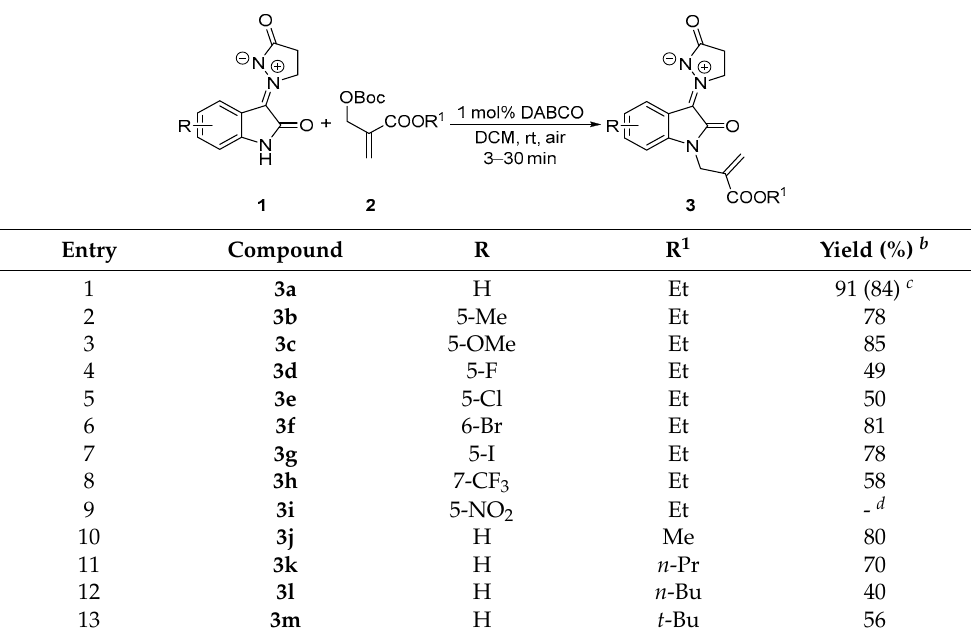
Table 2. Synthesis of N -allylated products 3 from isatin N , N ′ -cyclic azomethine imine 1 and MBH carbonates 2 a .